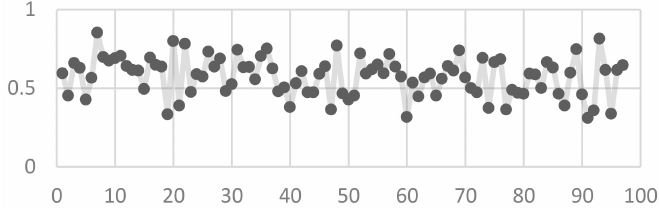
Figure 8. Correlation values between the experimental subject and the diabetic